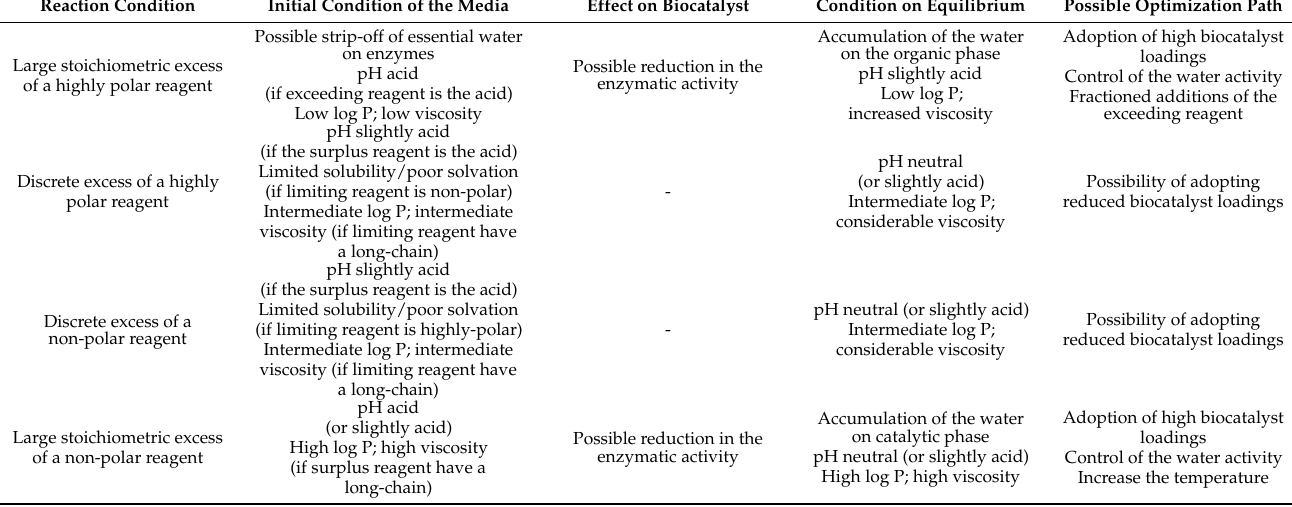
Table 2. Predictions of the behavior of enzymatic esterifications in different conditions of molar ratio using stoichiometric excess of